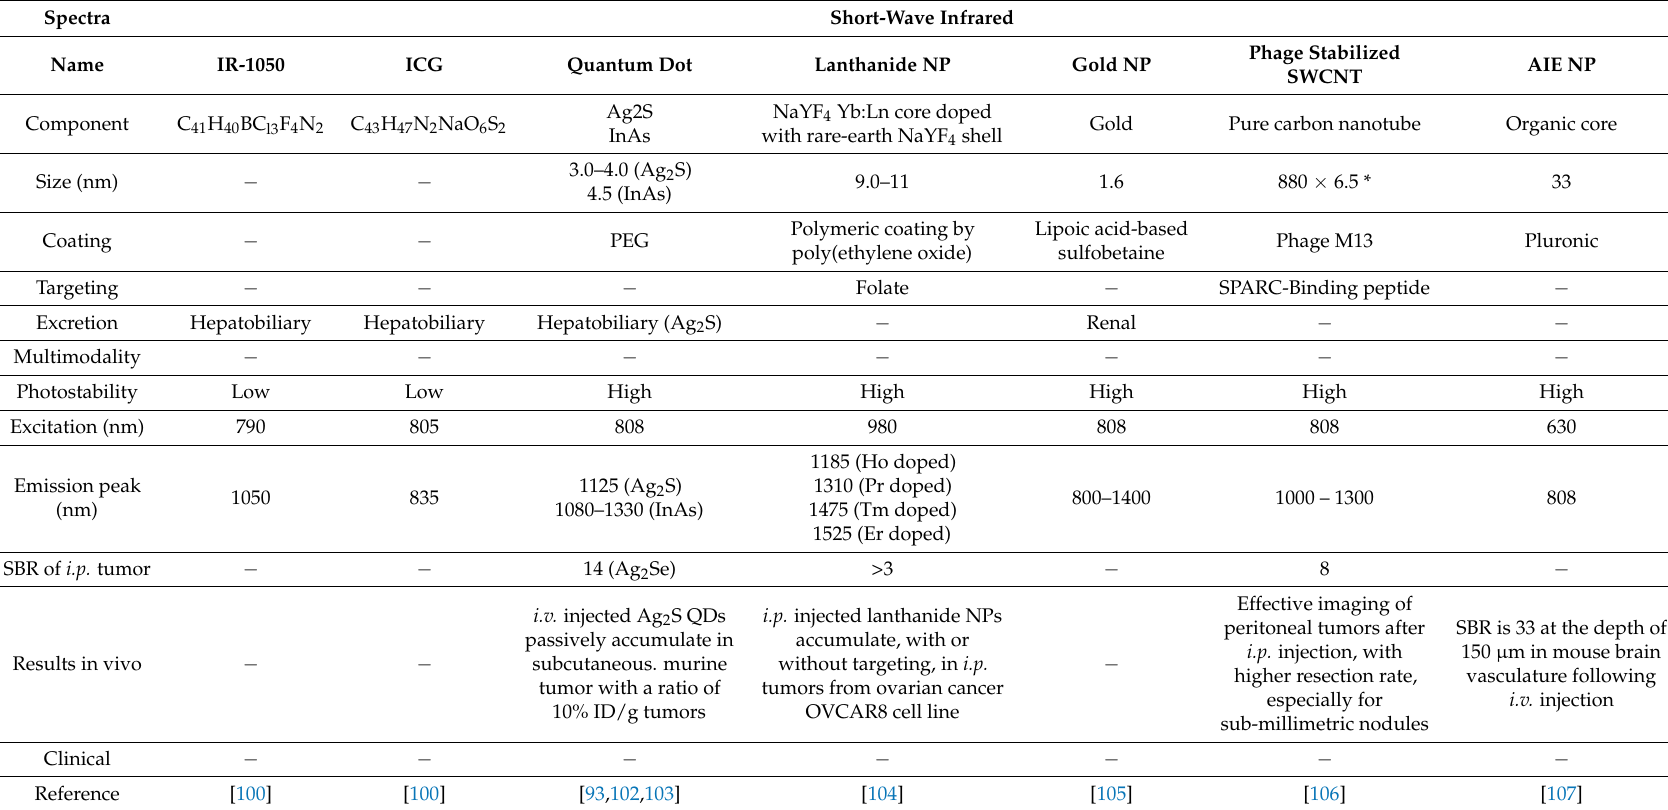
Table 2. Short-Wave Infrared fluorescent nanoparticles and their